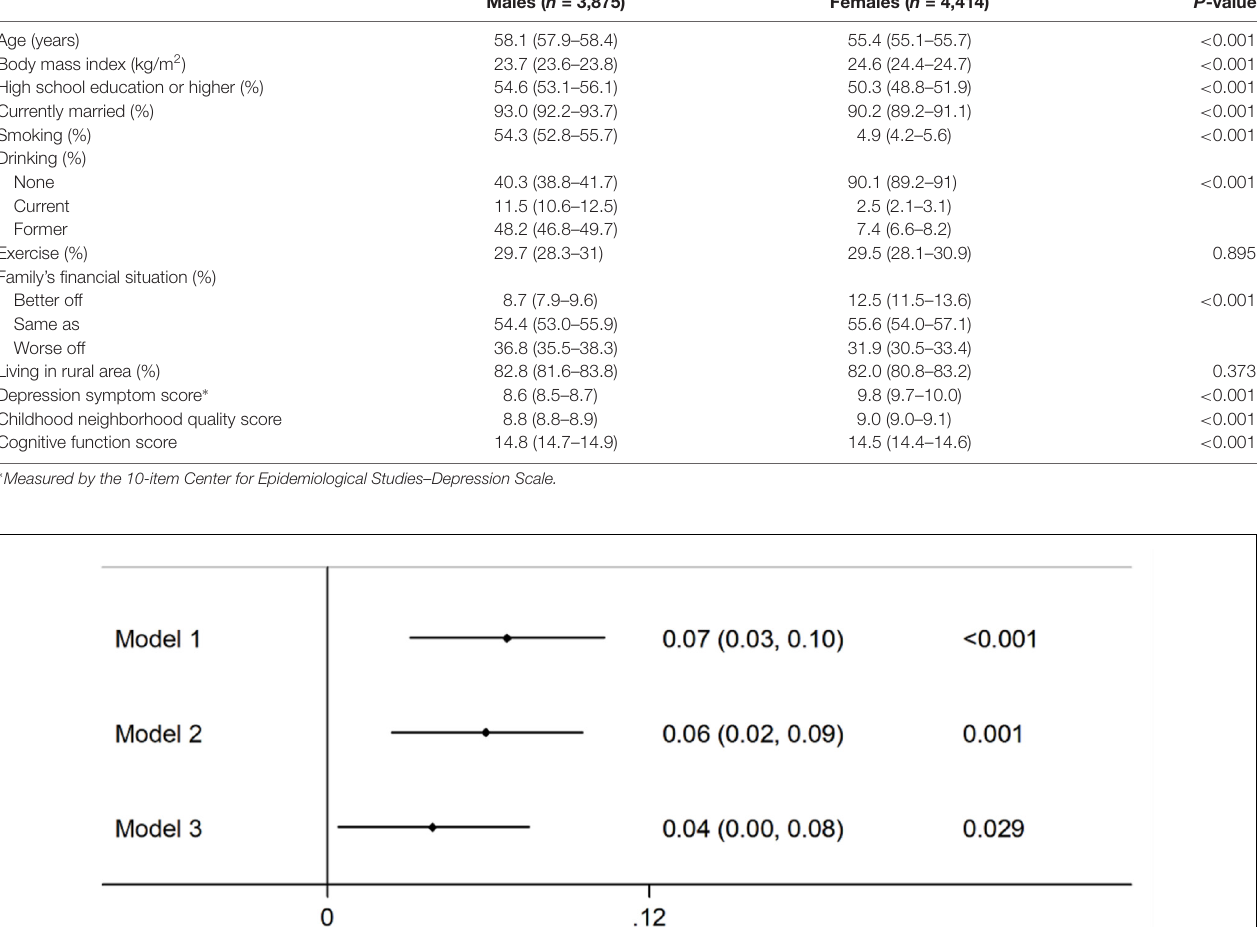
symptoms of the guardian. To our best knowledge, we firstly reported that there was an interaction of CNQ score with BMI level for the risk of cognitive dysfunction, indicating that